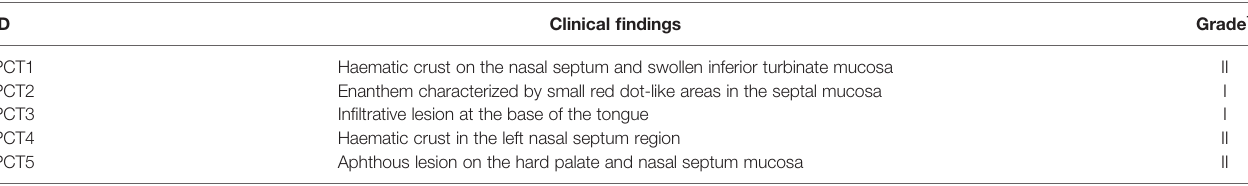
TABLE 1 | Description of early mucosal lesions of fi ve patients with cutaneous leishmaniasis with concomitant mucous lesions and a positive result for Leishmania braziliensis DNA from nasal swabs. ID Clinical fi